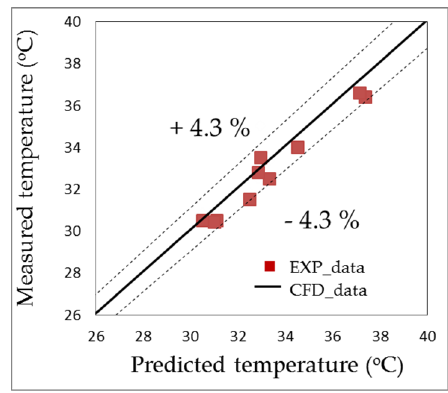
Figure 10. Measured temperature against the predicted temperature for all cases.